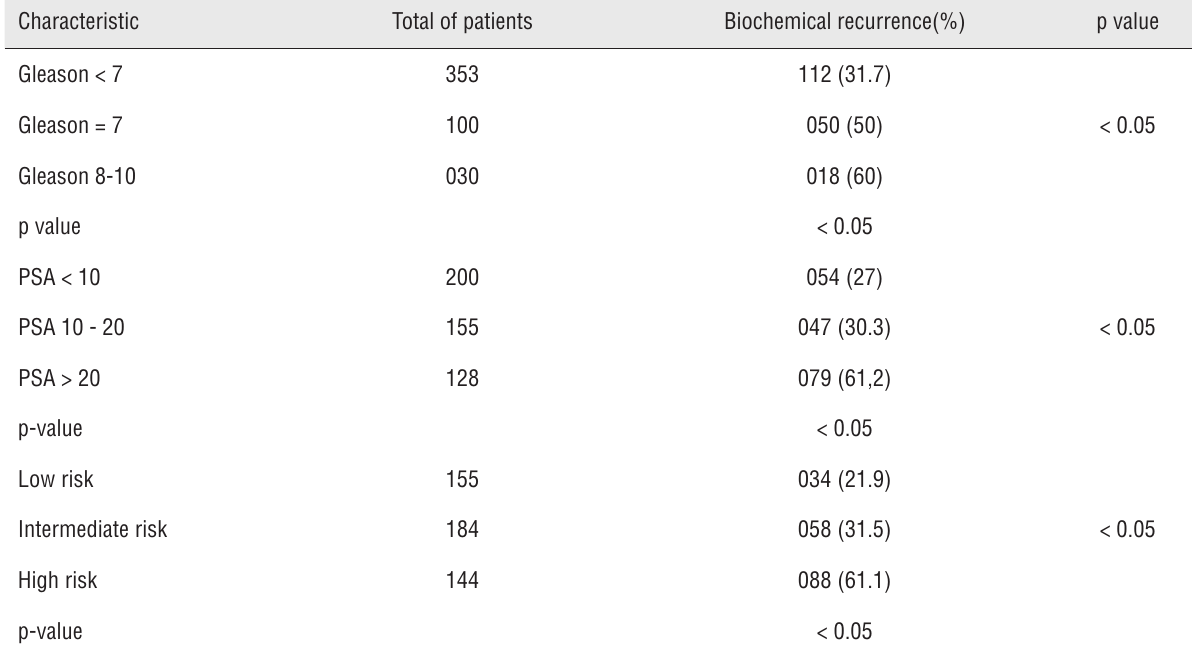
Table 4 - Biochemical recurrence according to